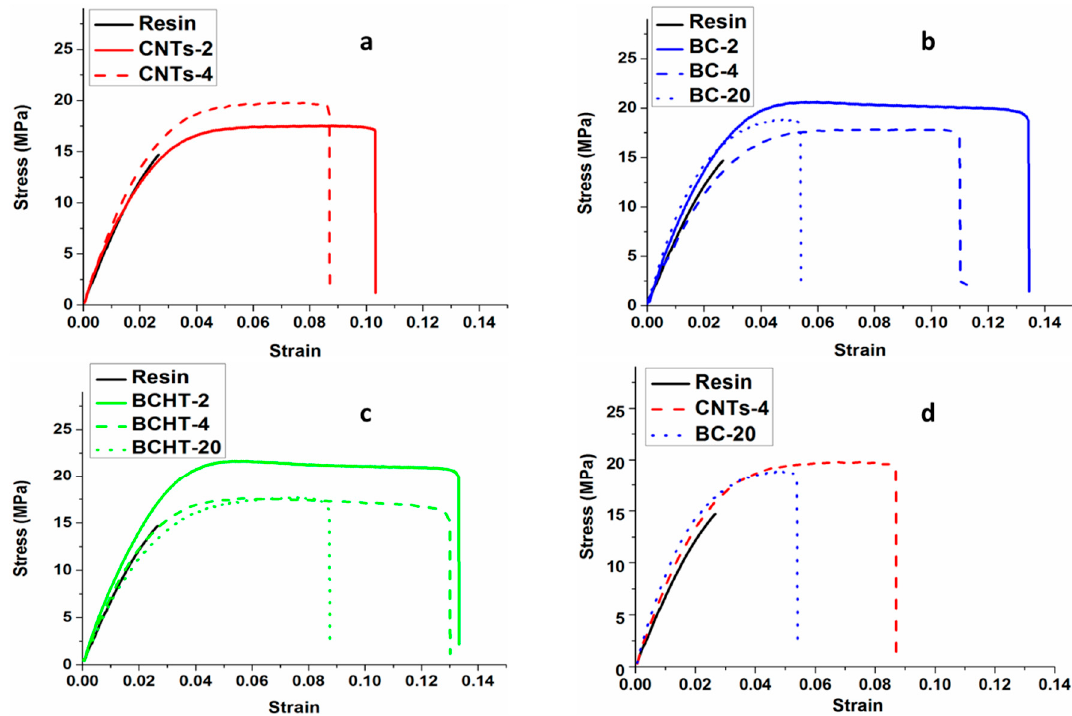
Figure 6. Stress vs. strain behavior of blank epoxy compared to ( a ) MWCNTs 2 and 4 wt %; ( b ) biochar 2, 4 and 20 wt %; ( c ) biochar HT 2, 4 and 20 wt %; ( d ) Comparison between blank epoxy, biochar 20 wt %, and MWCNTs 4 wt %.